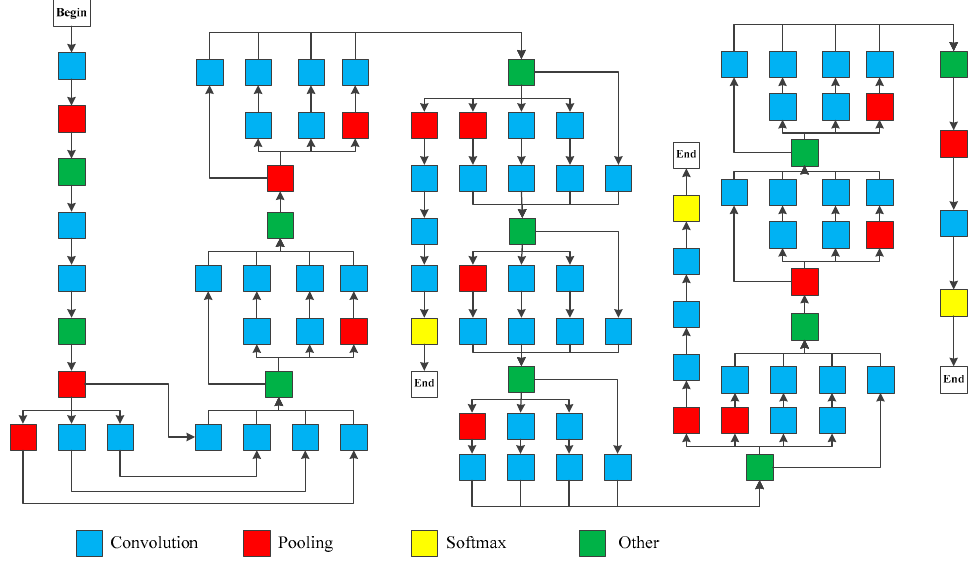
Figure 4. Structure of GoogLeNet.